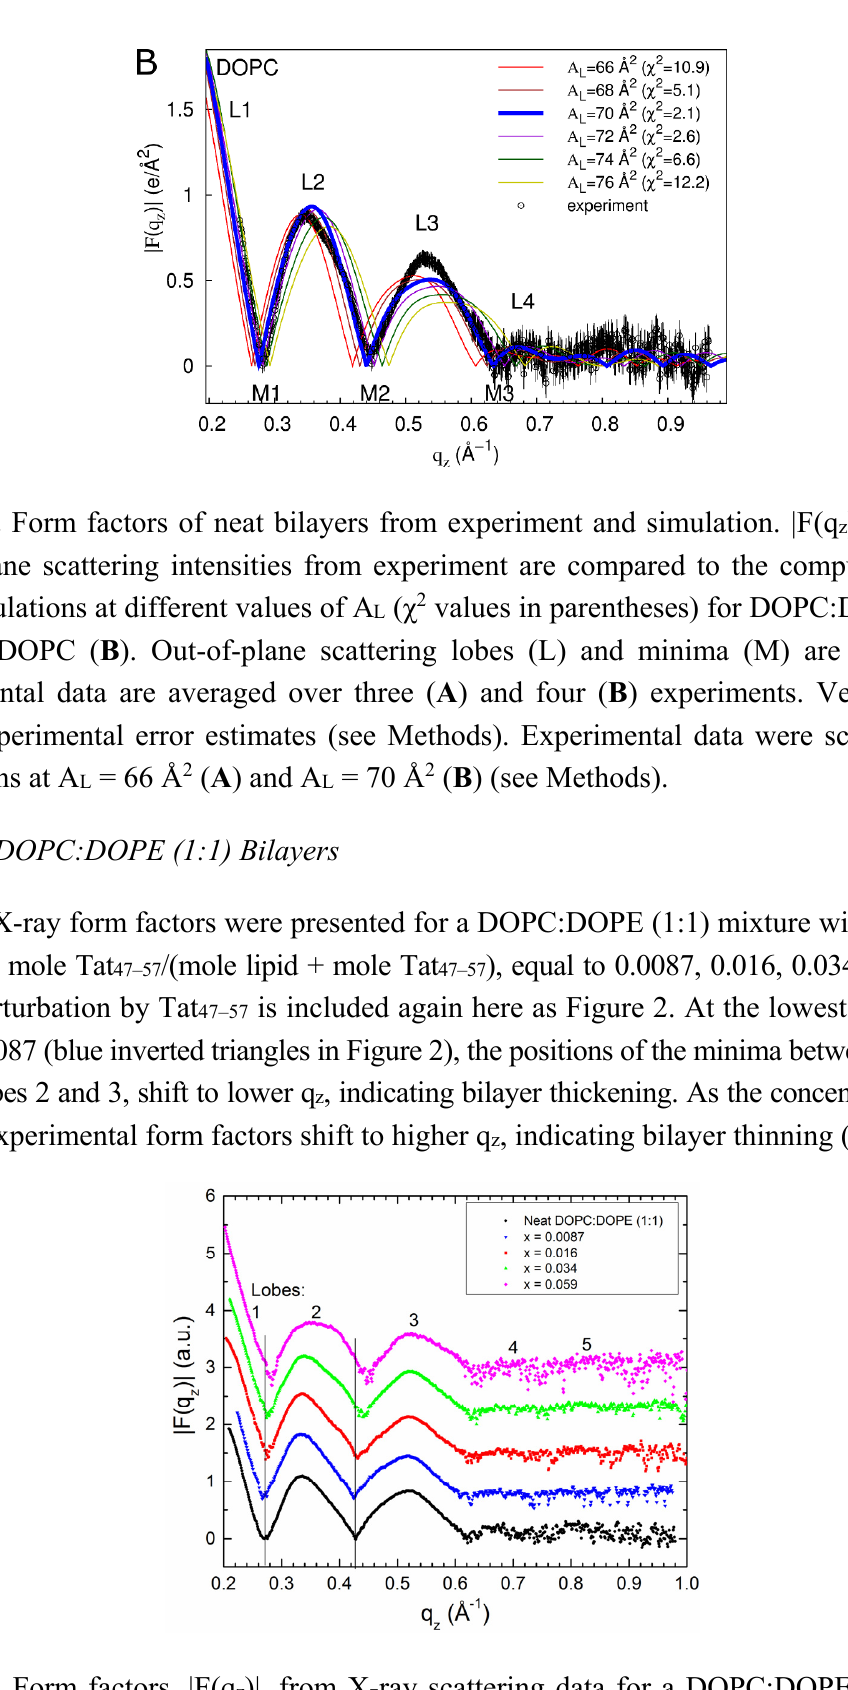
Figure 2. Form factors, |F(q z )|, from X-ray scattering data for a DOPC:DOPE (1:1) neat bilayer and increasing mole fractions, x, of Tat 47–57 . Traces are offset vertically for ease of viewing shifts in q z . The vertical solid lines indicate the zero positions ( i.e. , minima) of the neat DOPC:DOPE (1:1)